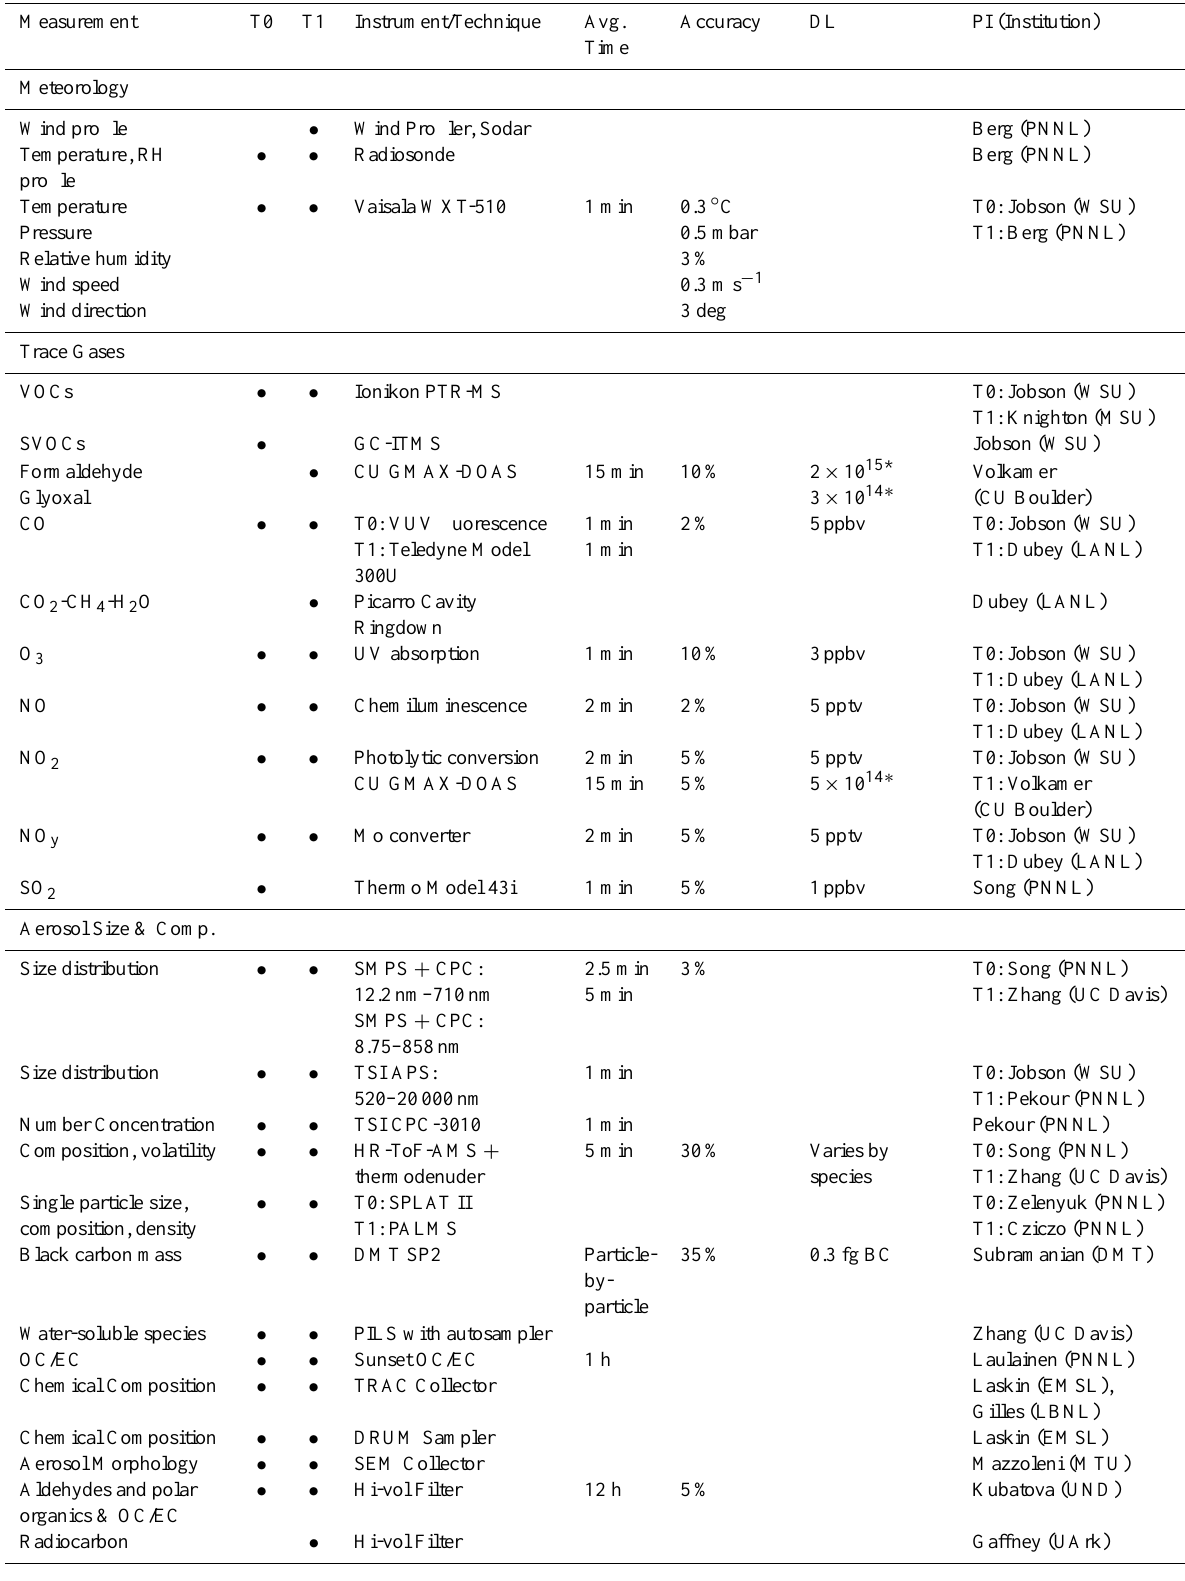
Table 1. Measurements and Instruments at the T0 and T1 Ground Sites. Measurement T0 T1 Instrument/Technique Avg.